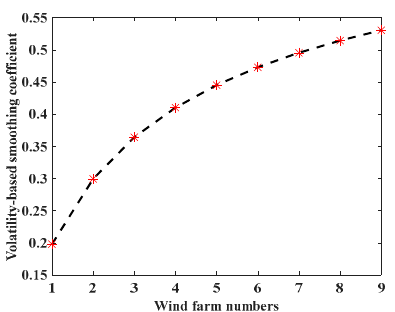
Figure 4. The volatility-based smoothing coefficient under different number of wind farms.